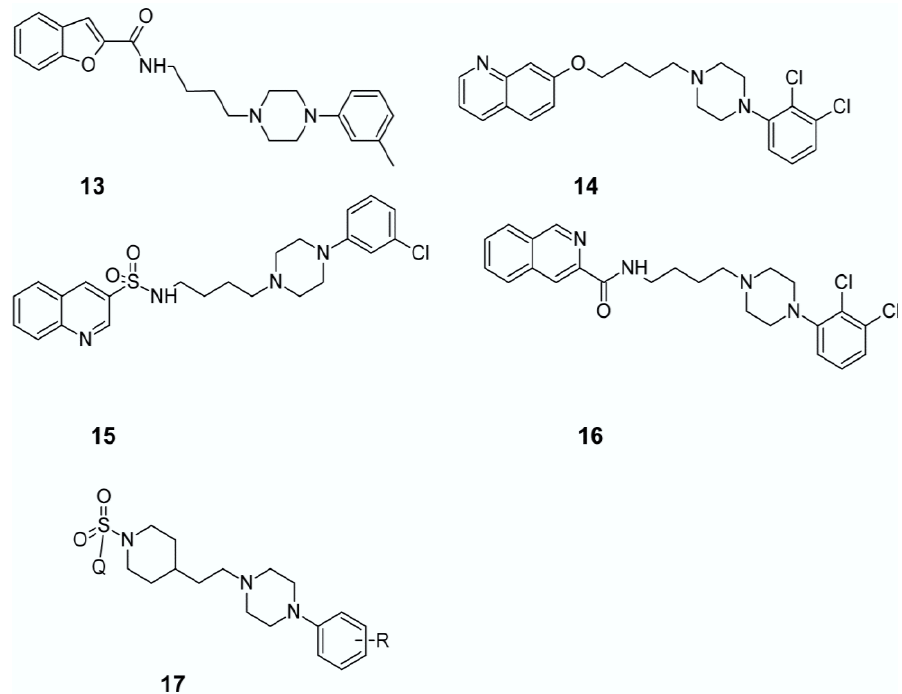
Figure 8. Novel potential multi-target antipsychotics derived from aripiprazole structure. Q: quinolone or isoquinoline.